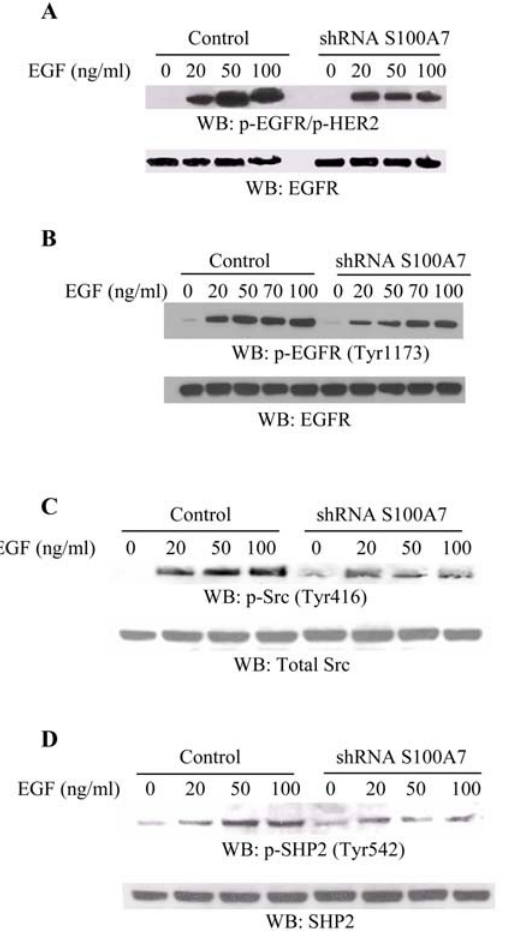
Figure 3. S100A7 downregulation decreases the phosphoryla- tion of EGFR/HER2, Src and SHP2 in MDA-MB-468 cell lines. Vector control and S100A7-shRNA stably-transfected MDA-MB-468 cell lines were starved overnight and stimulated with various concentra- tions of EGF (0 to 100 ng/ml) for 30 minutes at 37 u C. The cells were then lysed and the lysates were analyzed by Western blotting with p- EGFR Tyr1173/p-HER2 Tyr1248 (A, upper panel) or p-EGFR Tyr1173 (B, upper panel) antibodies. The protein levels were monitored by stripping the blots with anti-EGFR antibody (A and B, lower panels). Vector-transfected controls and S100A7 shRNA-transfected stable MDA- MB-468 cell lines were starved overnight for 17 hours and stimulated with various concentrations of EGF (0 to 100 ng/ml) for 15 minutes at 37 u C. The cells were then lysed and the lysates were analyzed by Western blotting with p-Src Tyr416 (C, upper panel) or p-SHP2 Tyr542 antibody (D, upper panel). The protein levels were monitored by stripping the blots with total Src and SHP2 antibodies, as indicated (C and D, lower panels). However, the involvement of S100A7 in the development of metastatic bone lesions and osteoclast formation at the site of metastasis is not known. Breast cancer cells that metastasize to the bone commonly cause osteolytic lesions, which are mediated by osteoclasts. Direct injection of cancer cells into mouse bone has been used as a model to analyze bone metastasis in renal carcinoma [24] and prostate cancer [25]. Here, we employed the orthotopic bone implantation model to analyze the formation of osteolytic lesions in mice. Intra-tibial injections in mice were carried out as described in Materials and Methods. We observed osteolytic lesions as well as destruction of the cortex, with tumors